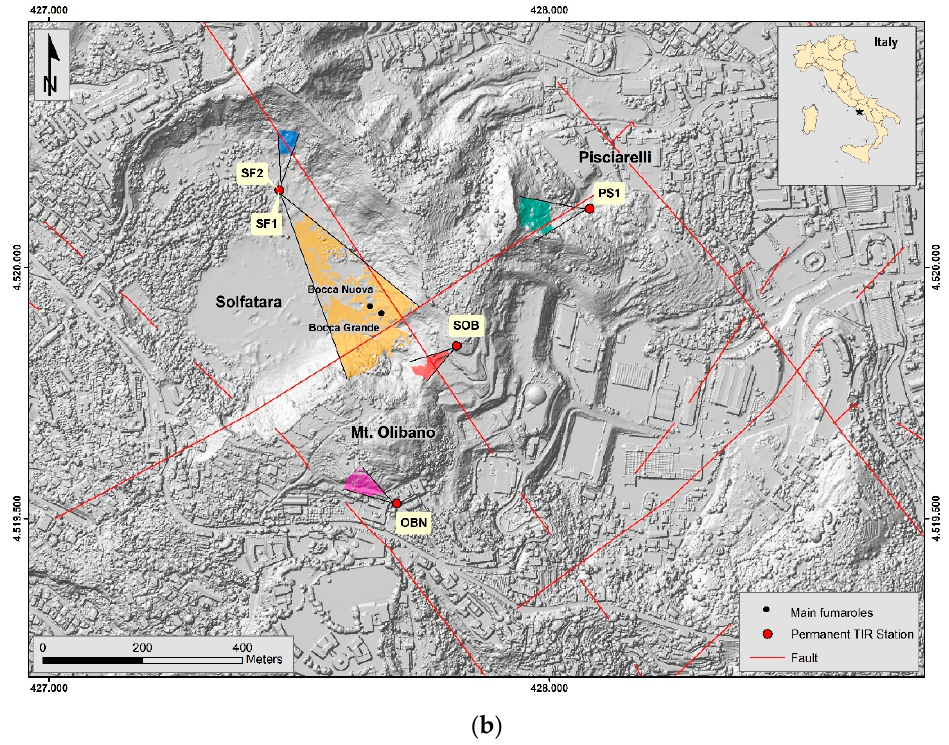
Figure 1. TIR network. ( a ) On the left, CFc TIR cameras (red dots) and Capo Miseno meteo station (green dot). On the right, Vesuvius TIR camera (red dot); ( b ) Digital Terrain Model (DTM) of Solfatara crater [24] with locations of TIR stations (red dots) and studied framed areas (orange, blue and green areas) mapped in GIS environment using Field of View (FoV) values of infrared sensors (After Caputo et al. [15], Figure 1a).